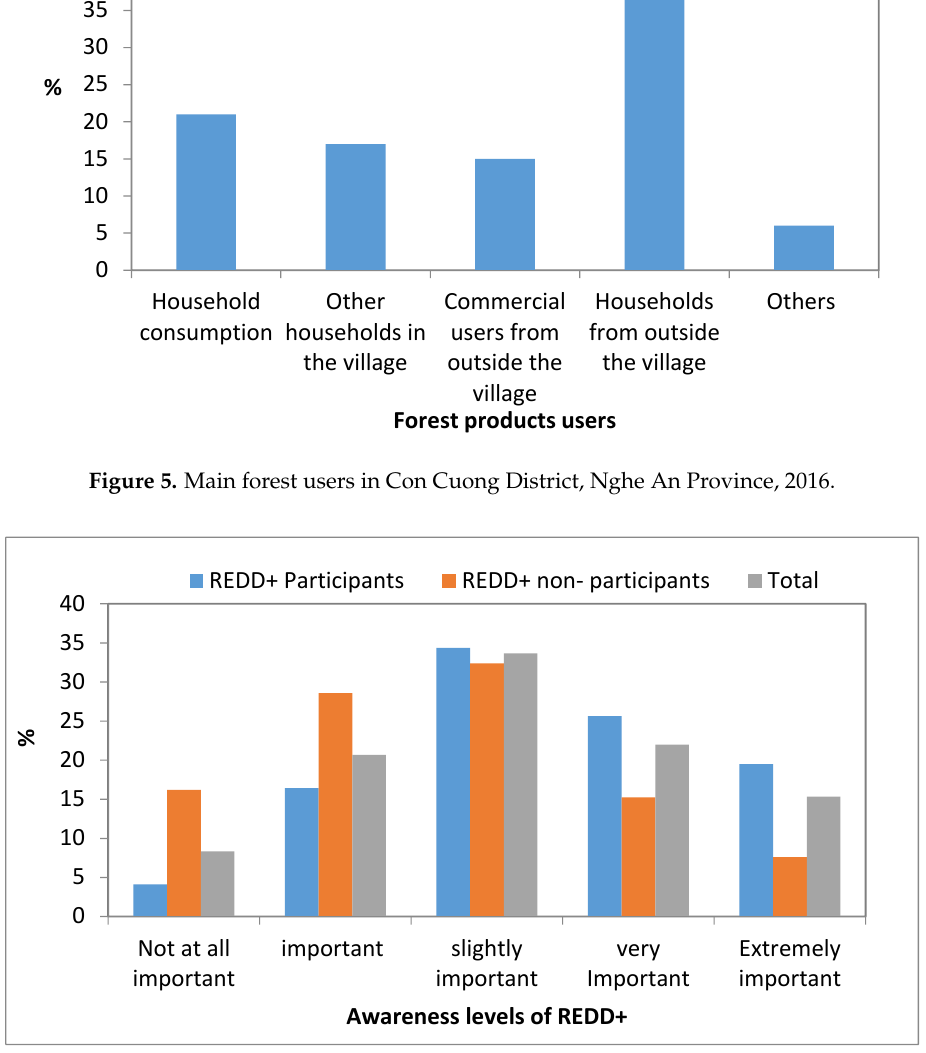
Figure 5. Main forest users in Con Cuong District, Nghe An Province, 2016.